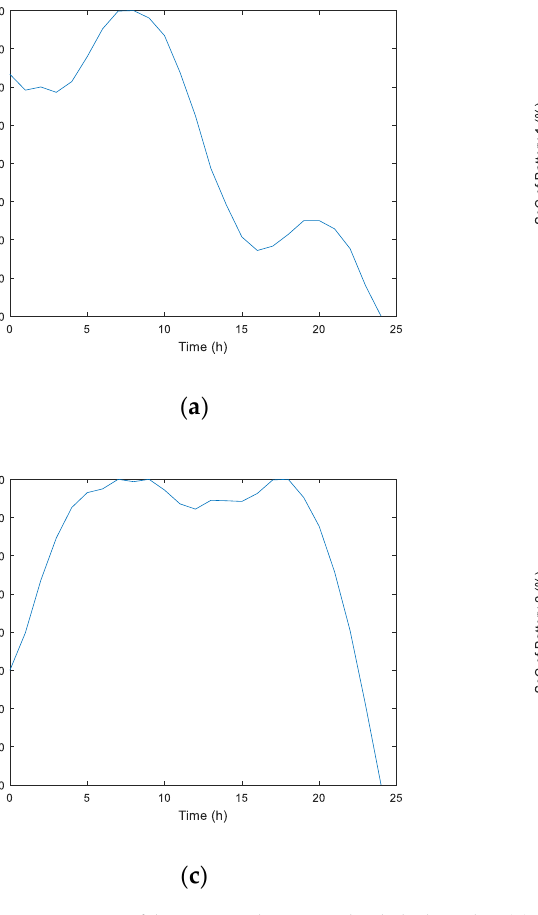
Figure 6. SoC of batteries during scheduled 24 h: ( a ) Prosumer 1, COF; ( b ) Prosumer 1, MOF; ( c ) Prosumer 2, COF; ( d ) Prosumer 2,